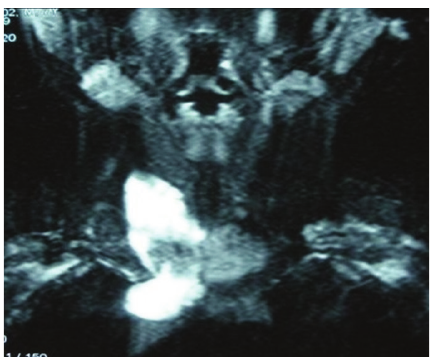
Figure 1: A 2 cm painless mass on the right side of the neck in a 7-year-old patient.